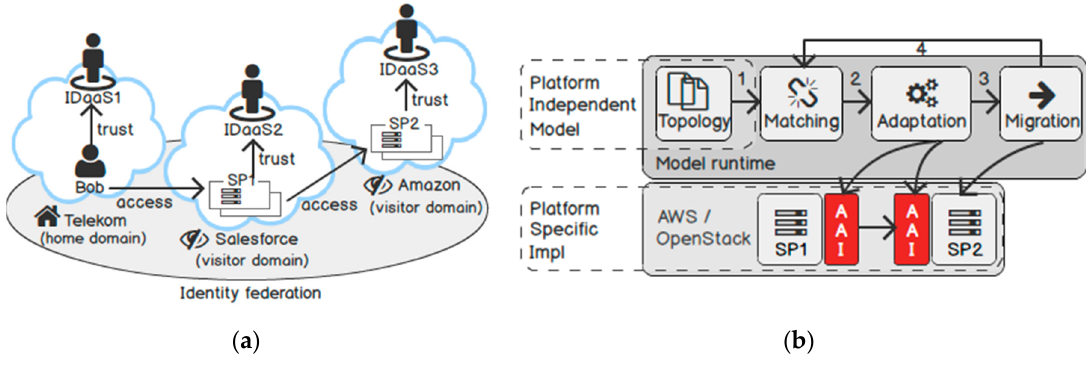
Figure 3. ( a ) Trust model; ( b ) Trust adaptation process.